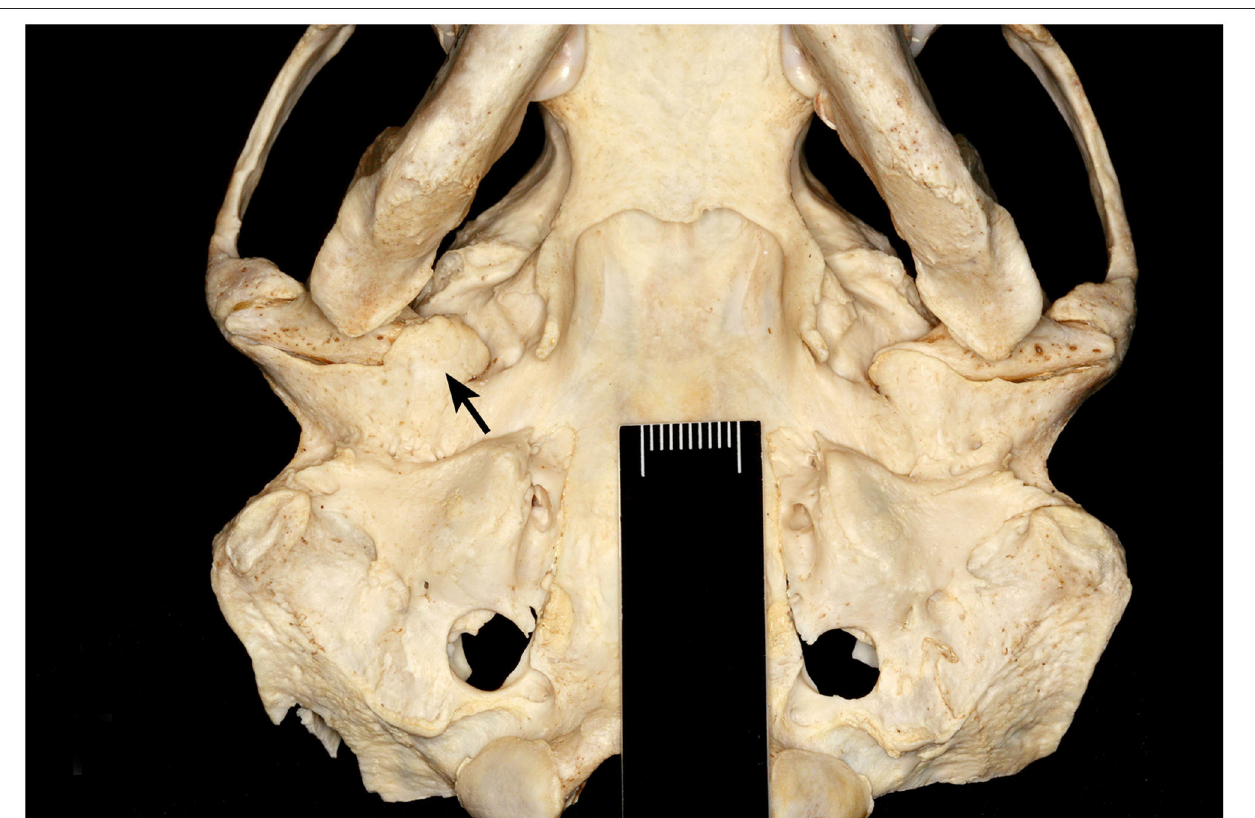
FIGURE 1 | Ventral view of severe TMJ-OA of a male southern sea otter ( Enhydra lutris nereis ). Bony proliferation at the right retroarticular process (arrow) encircles the mandibular head, resulting in an inability to disarticulate the joint. Scale, 10